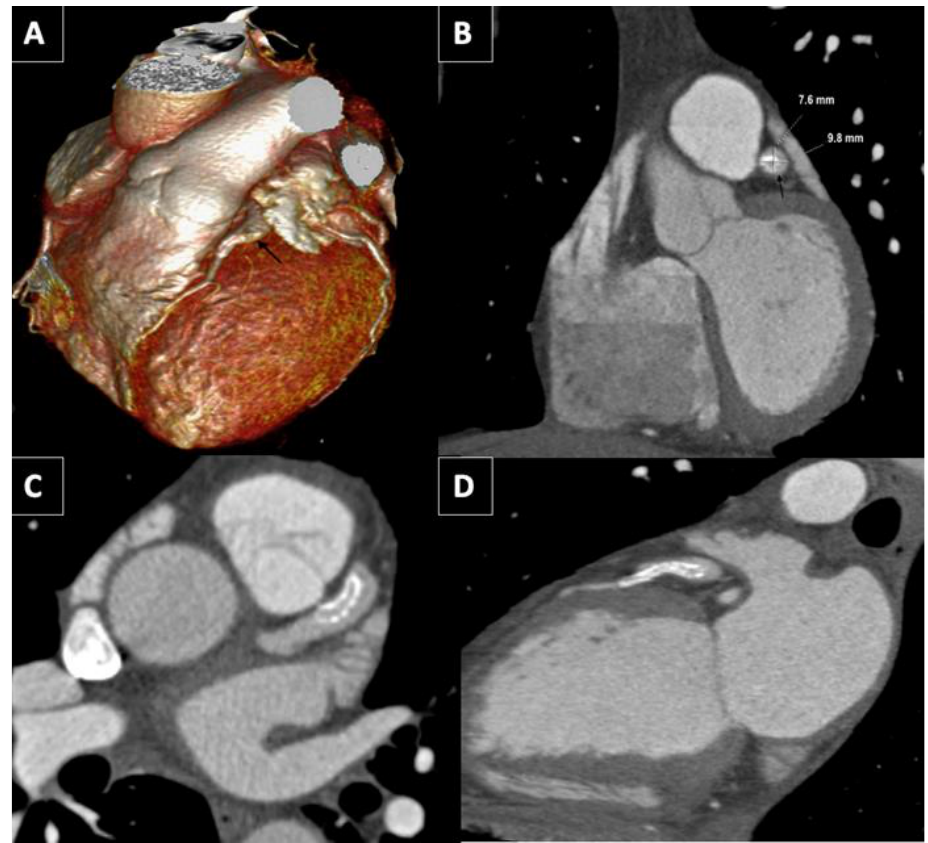
Figure 2. CCT. ( A ) GCA (black arrow) lateral view on three-dimensional volume-rendered CCT. ( B ) Coronal view of GCA (black arrow) with dimensions in CCT. Axial ( C ) and sagittal oblique ( D ) view of GCA showing the stent “floating” in the aneurysm with a “funnel” -like form disposition.